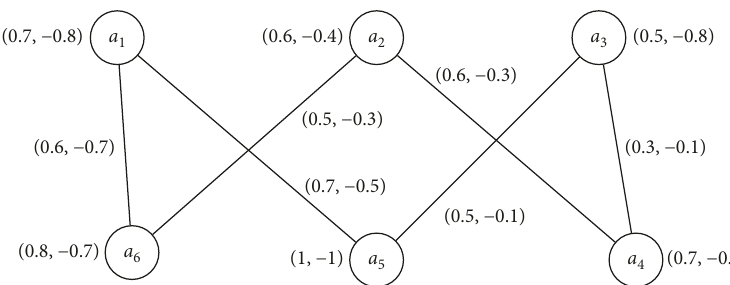
Figure 1: Example of the bipolar-valued fuzzy graph over graph